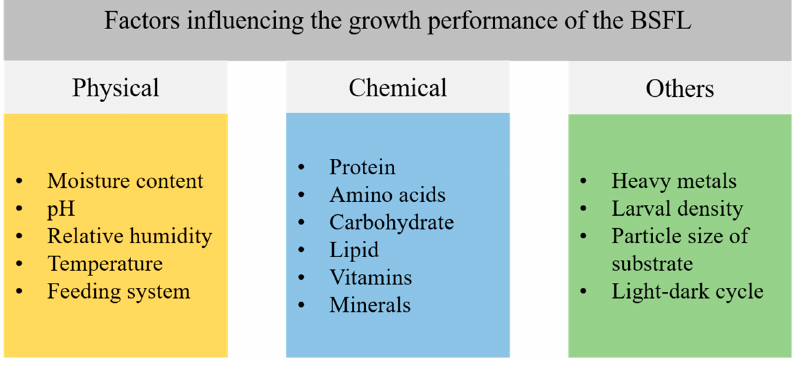
Figure 11. Factors influencing BSFL growth.